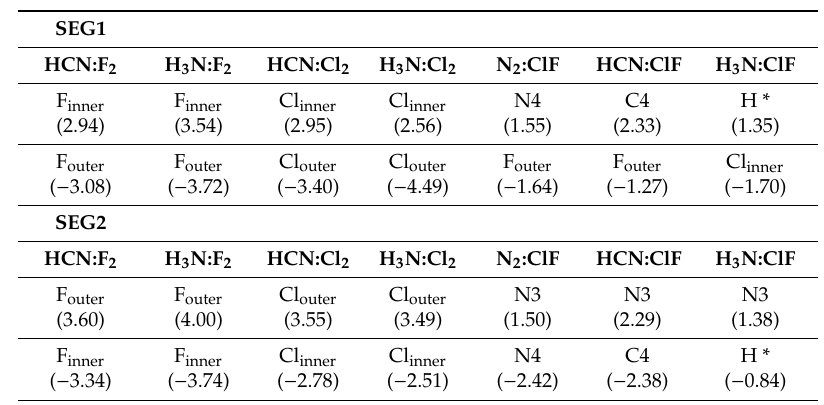
Table 3. REG analysis of the total atomic energies E A (Level 1). For each complex, two atoms are listed, IQA that with the most positive and that with the most negative REG value (dimensionless, see Equation (8)). The REG values are shown in parentheses. The atomic labeling follows X outer –X inner ··· N 3 - etc. where X = Cl or F, and the numeric labels of atoms not marked in this core common scheme increase while moving away from X inner